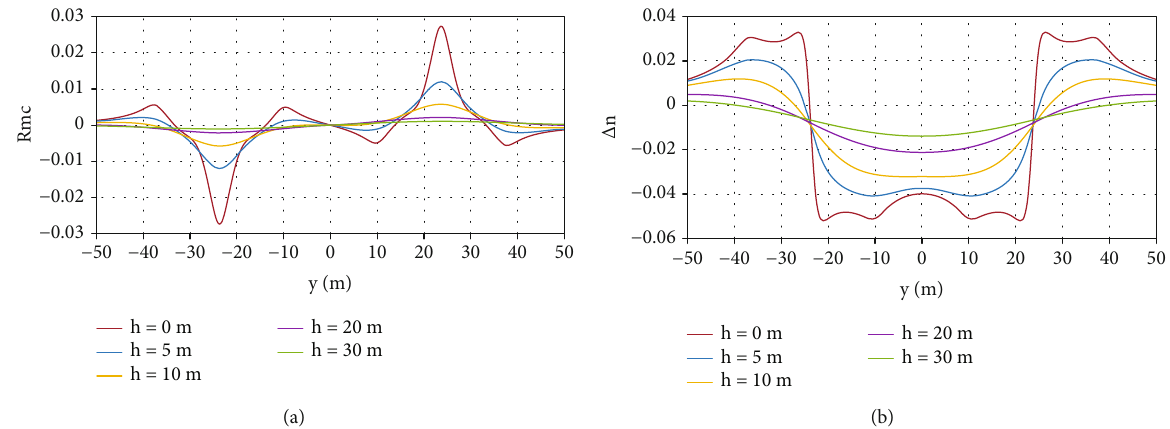
Figure 15: The overall coe ffi cient of the ARJ21 with the spanwise position of the wake vortex fi eld at di ff erent heights.